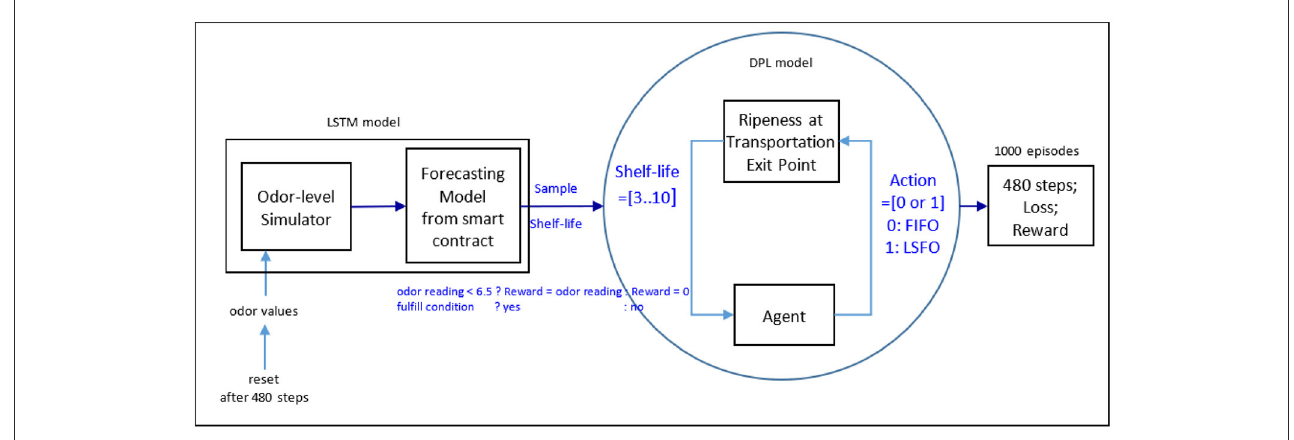
FIGURE5 Deep Q-learning with simulated forecast